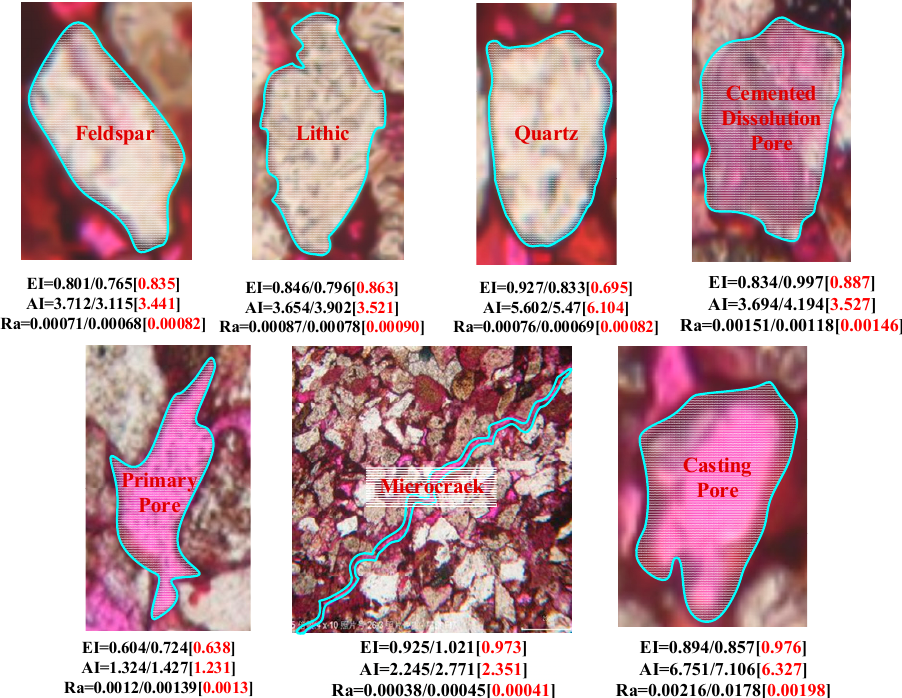
Figure 6. EI, AI and Ra calculation results of each component profile of tight sandstone thin section images.